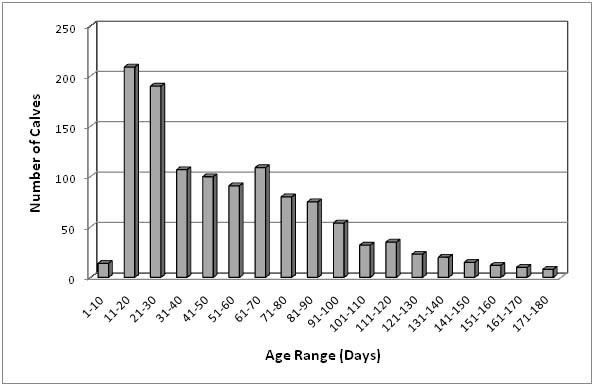
Frequency distribution of the age of animals, up to 180 days of age, among young stock diagnosed as shedding Giardia during the study period. The range is measured in ten-day intervals.